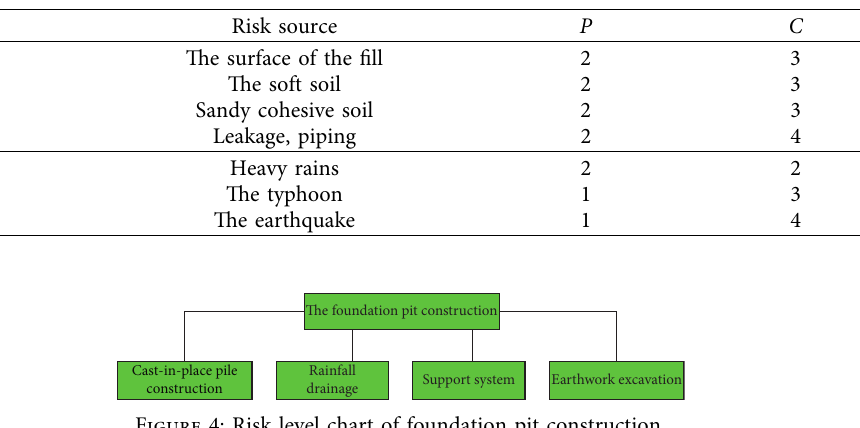
Table 18: Geological and natural risk list.